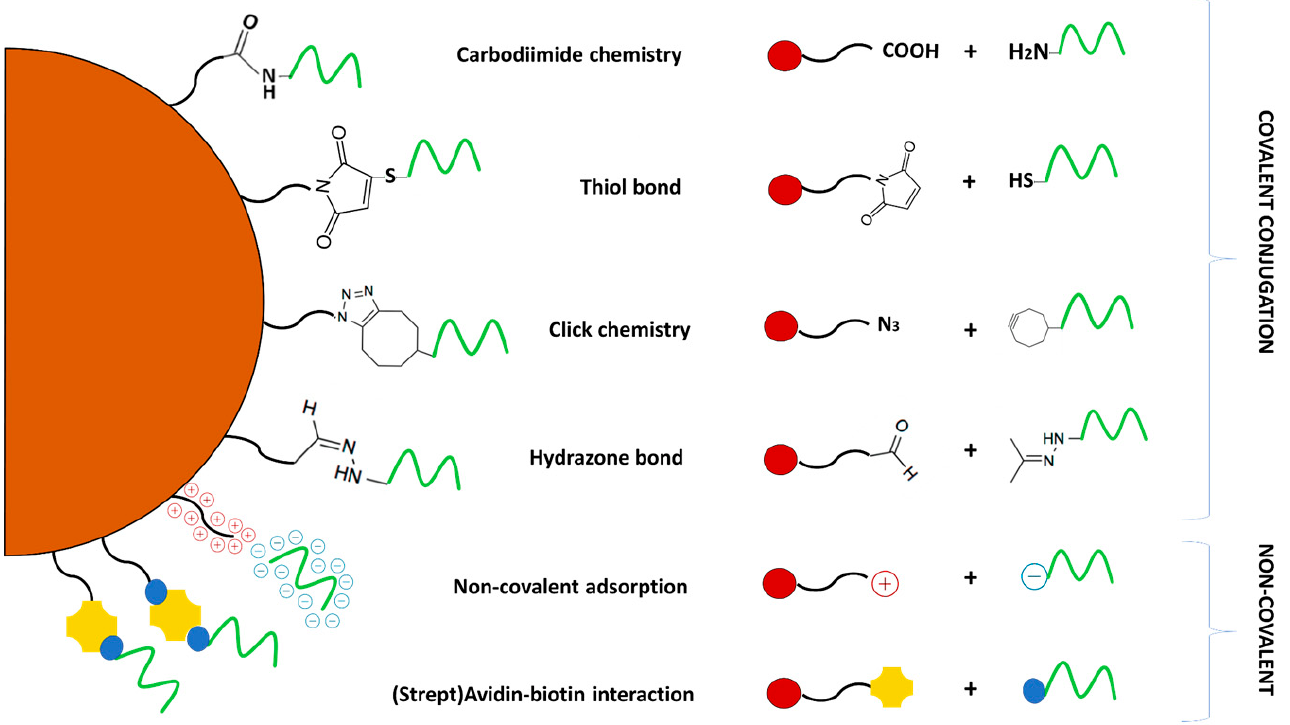
Figure 2. Schematic representations of covalent and non-covalent conjugation approaches.